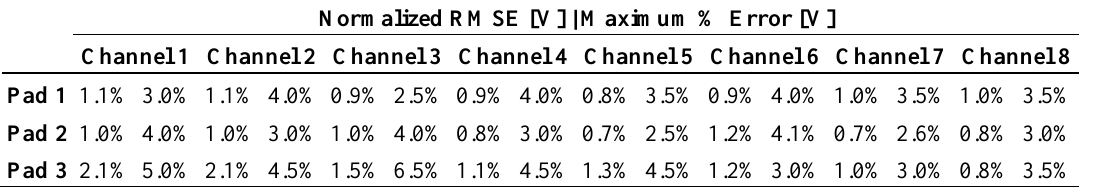
Table 1. Normalized root mean square error of the signal, compared with the fitting, and maximum percentage error (relative to the full scale range), of the eight channels for each of the three pads used in this